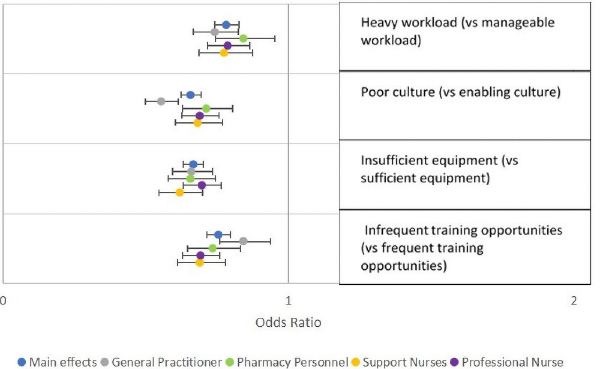
Fig 1. Preferences regarding workload, culture, availability of equipment and opportunities for training by healthcare worker cadre. This figure shows results of models stratified by cadre, including odds ratios and 95% confidence intervals, for attributes related to workplace conditions.